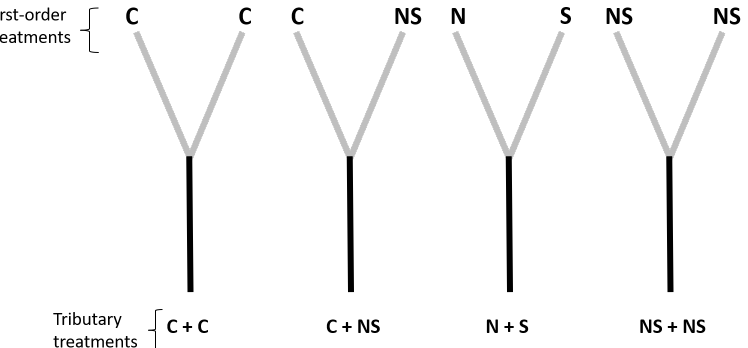
Figure 1. Schematic representation of our experimental channel-network set up. Each pair of first- order channels (represented as gray bars) is a treatment for its second-order receptor (black bars). Initials are used to represent stressor additions in first-order treatments (C, control; N, nutrients; S, sediment; NS, nutrient and sediment). Combinations of tributaries represent treatments to second- order channels (C + C, two control tributaries; C + NS, one control tributary and one tributary with both stressors; N + S, nutrients added in one tributary and sediment in the other; and NS + NS, nutrients and sediment added in both tributaries). There were three replicates of each tributary treatment for a total of 12 second-order channels and 24 first-order